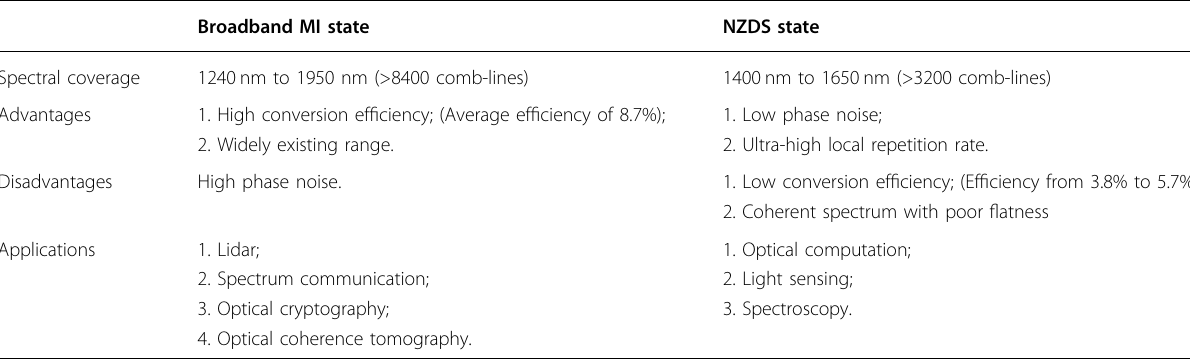
Table 1 The comparison of broadband MI state and NZDS state Broadband MI